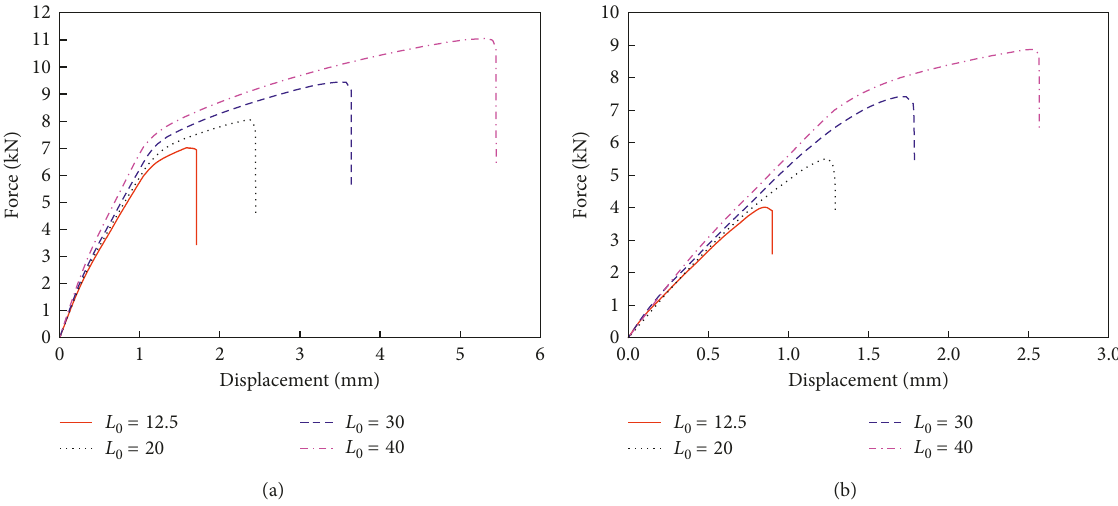
Figure 3: Tensile mechanical properties for joints using (a) 7779 structural adhesive and (b) MA830 structural adhesive.